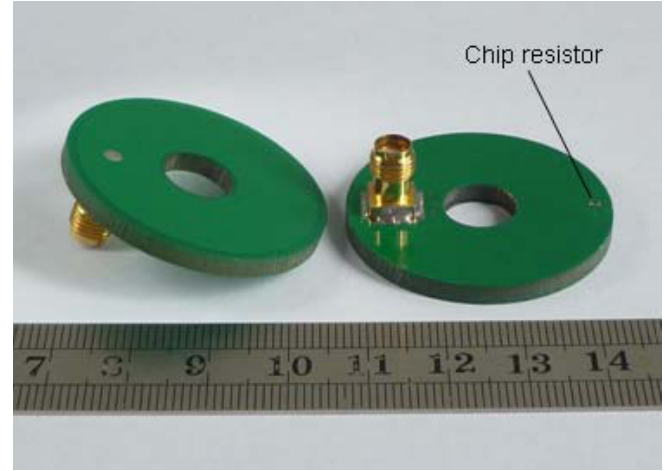
Figure 6. Photograph of the fabricated antenna.